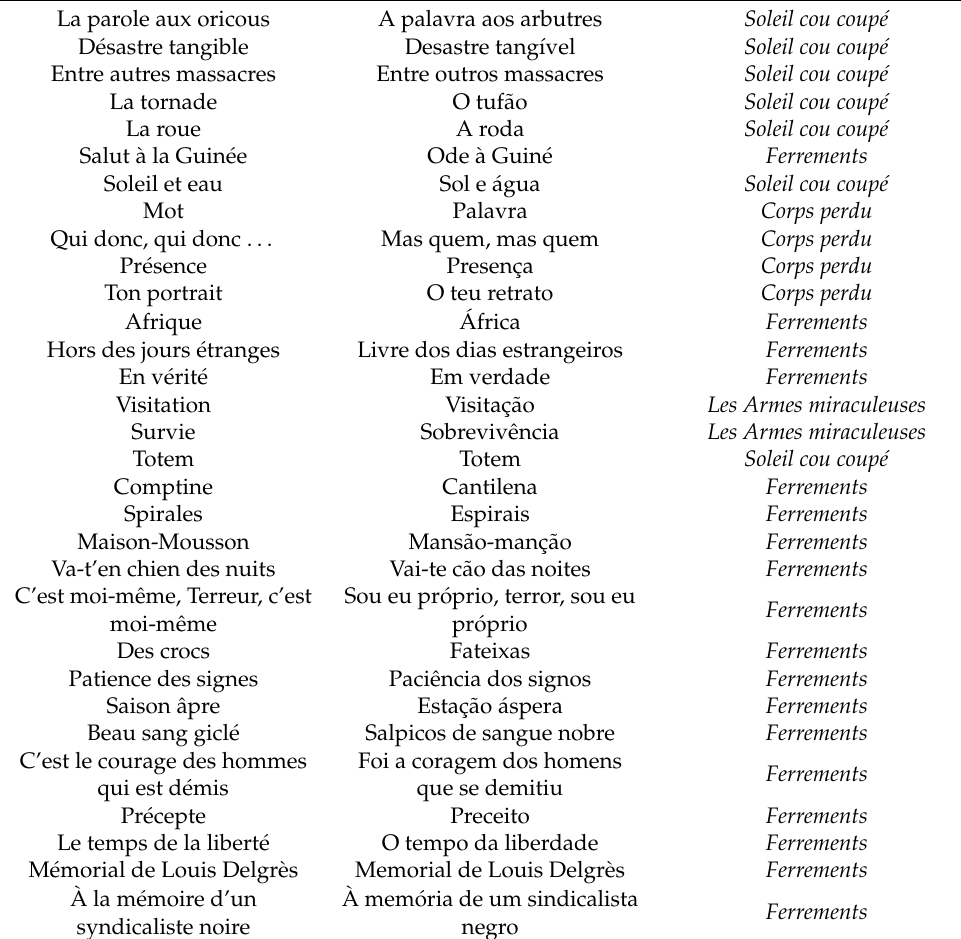
Table 1. List of poems in the Antologia po é tica , with original titles and source. La parole aux oricous A palavra aos arbutres Soleil cou coup é D é sastre tangible Desastre tang í